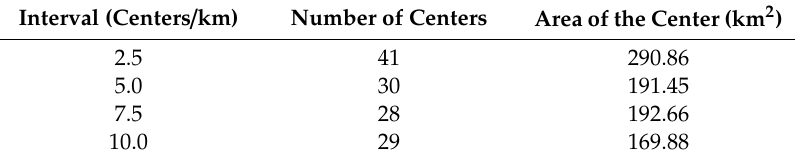
Figure 11. Location and boundary of the distribution center of the ( A ) accommodation and ( B ) catering industry, extracted at di ff erent contour intervals. Table 3. Influences of di ff erent contour intervals on the number and area of the extracted cluster